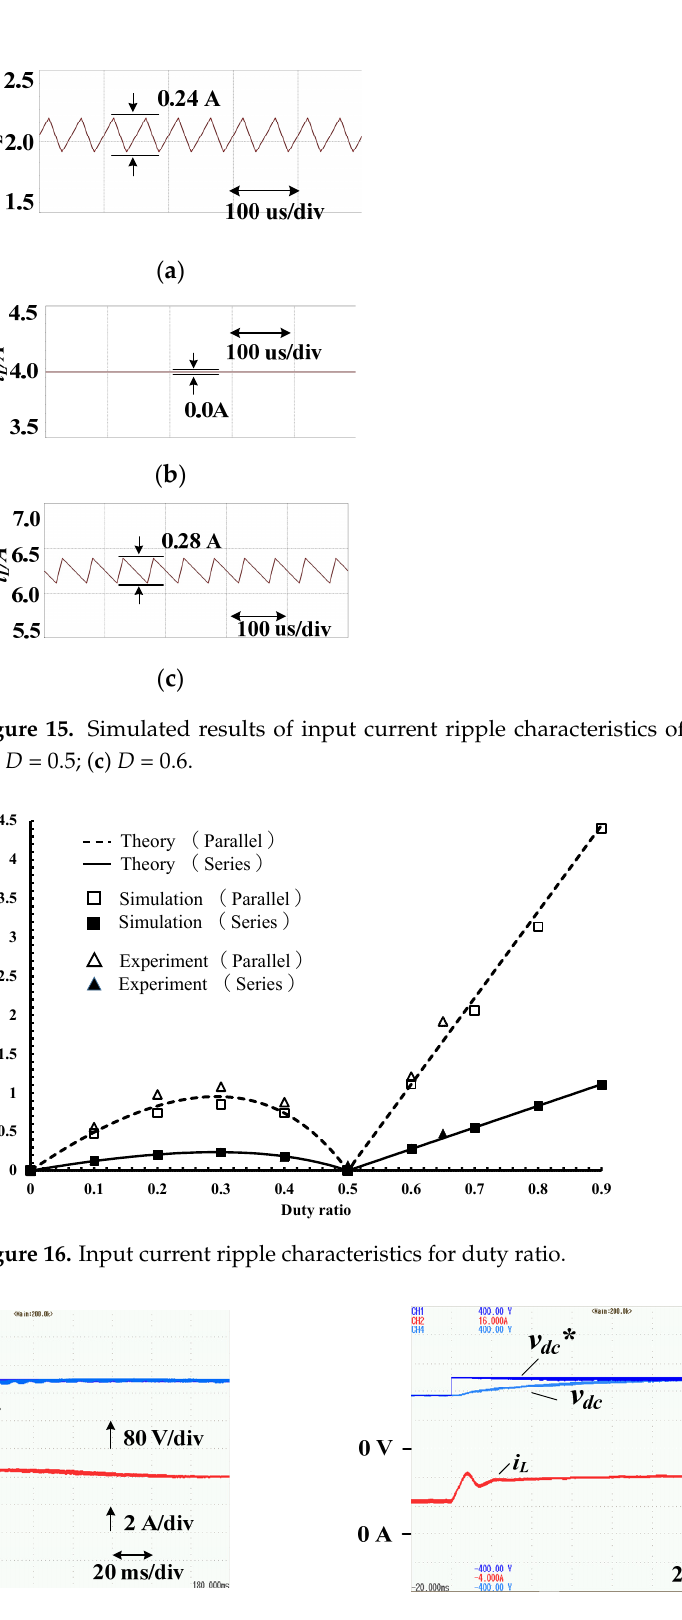
( a ) ( b ) Figure 18. Load variation (200 W to 500 W). ( a ) PI control; ( b ) LQR. ( a ) ( b ) Figure 19. Load variation (500 W to 200 W). ( a ) PI control; ( b ) LQR. 5.6. Efficiency Characteristics Figure 20 shows the characteristics of conversion efficiency versus output voltage. When the load power is 500 W, the parallel circuit has high efficiency when the output voltage is 160 V (duty ratio 0.38) or lower. At higher output voltages, the series circuit is highly efficient. When the load power is 800 W, the series circuit is higher in efficiency when the output voltage is 240 V (duty ratio 0.58) or higher. Thus, the conversion effi- ciency of the series circuit is higher than that of the parallel circuit at light loads and high output voltages. Figure 21 shows a comparison of the efficiency with respect to the load. As for 280 V, the efficiency of the series circuit is higher than that of the parallel circuit over the entire range. As for 200 V, the efficiency of the series circuit is higher below 630 W. When the load power is 300 W, the efficiency of the series circuit is 96%, compared to 92% for the parallel circuit. These results show that the series circuit has an advantage in conversion efficiency in the light load and high voltage range. Figures 22 and 23 show the loss sepa- ration results for the parallel and series circuits. When the output power is 500 W, the